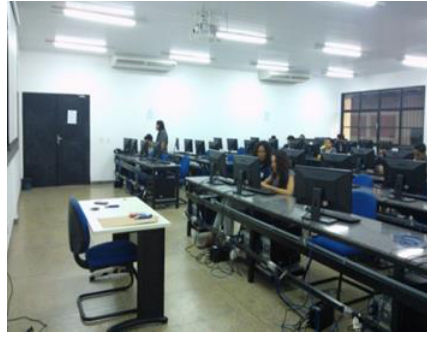
Figure 1. Classroom with